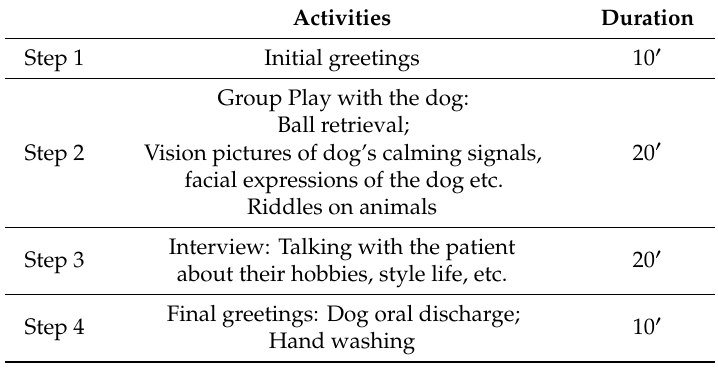
Table 1. Operative sequence of a session of AAA with the dog for dialysis